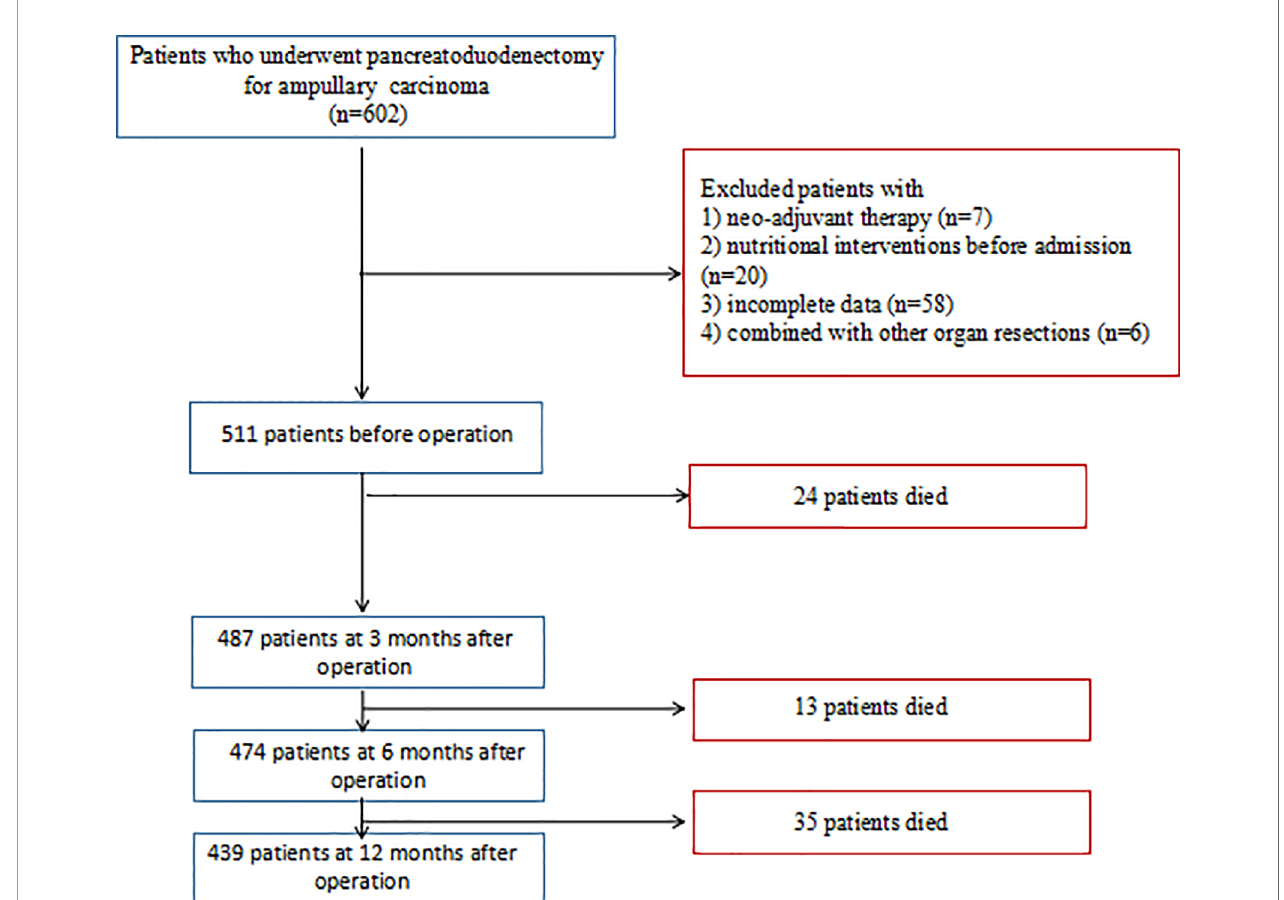
FIGURE 1 | Flow diagram of before surgery and at 3, 6, and 12 months after